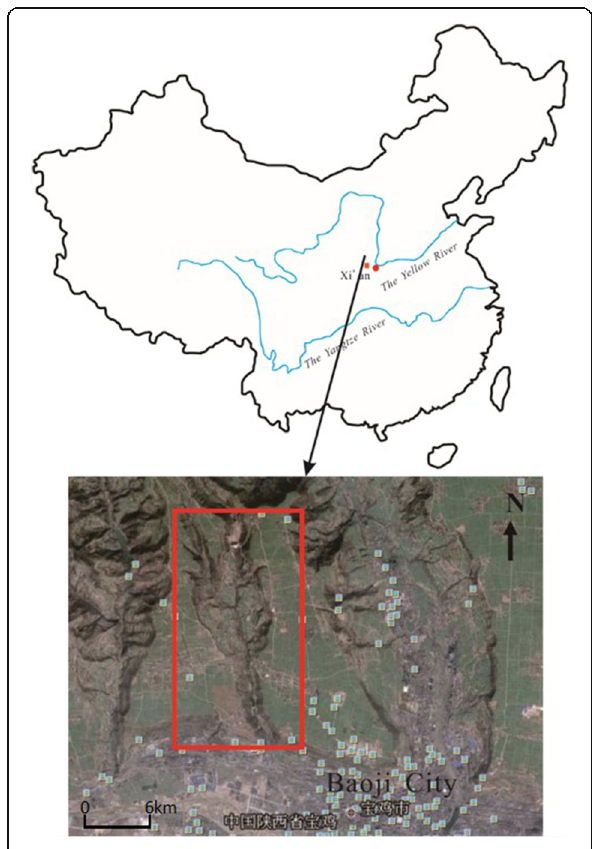
Fig. 1 Geographical location of the study area marked by the red rectangle (data from Google earth)